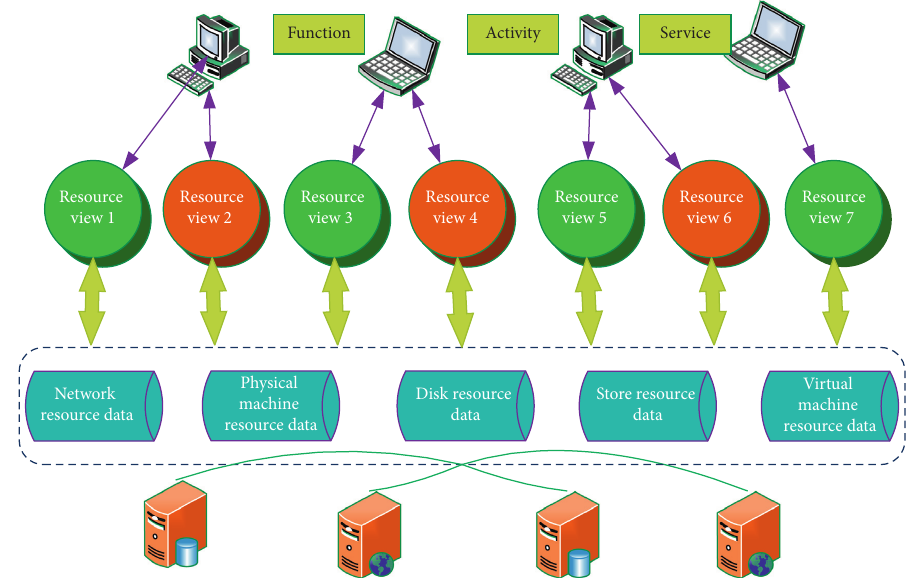
Figure 3: Task-oriented view of network